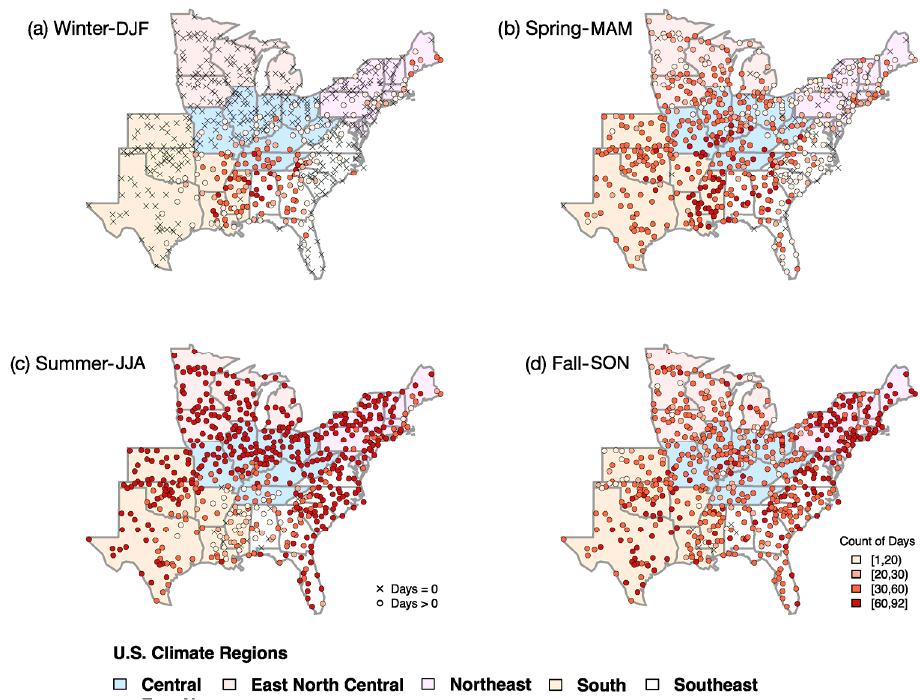
Figure 6. The strength of station-by-station seasonal mode. The season is strong when the significant empirical probability distribution function lasts for 92 days. The threshold of the significant mode for the season is 20 days.